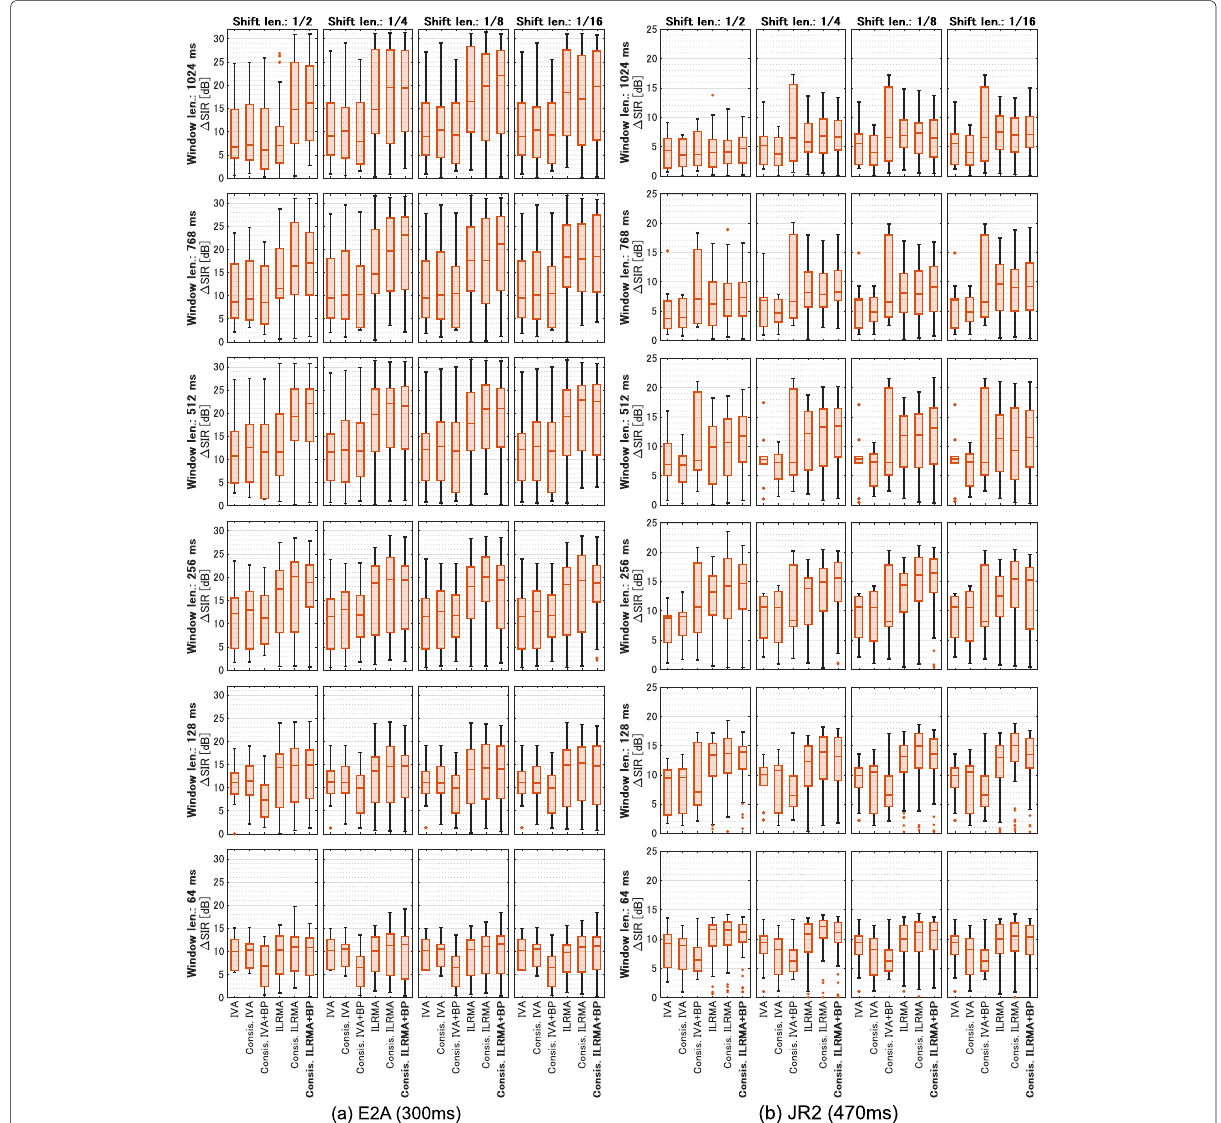
Fig. 16 Average SIR improvements for synthesized music mixtures (music 1–10) with a E2A and b JR2 , where Hann window is used in